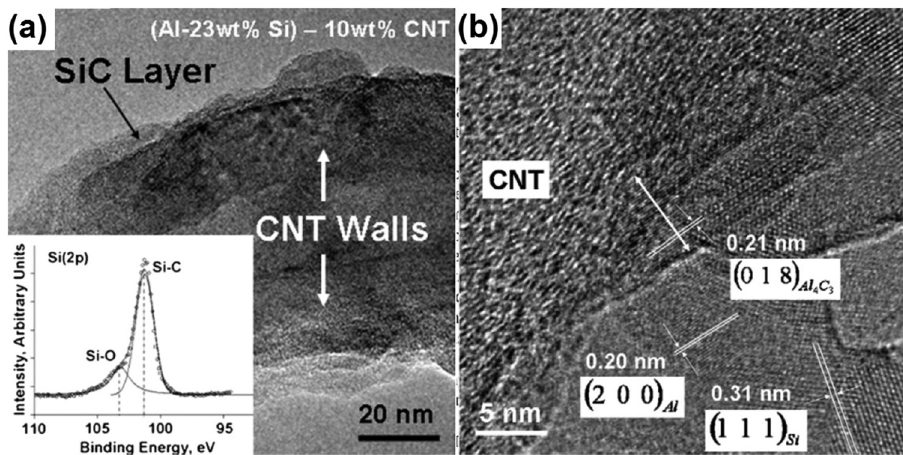
Figure 11: High - resolution TEM images of ( a ) an Al – 23 wt% Si alloy reinforced with 10 wt% CNTs ( inset shows the XPS validating SiC ) and ( b ) an Al – 11.6 wt% Si alloy containing 10 wt% CNT ( Reproduced with permission from [ 46 ] . )